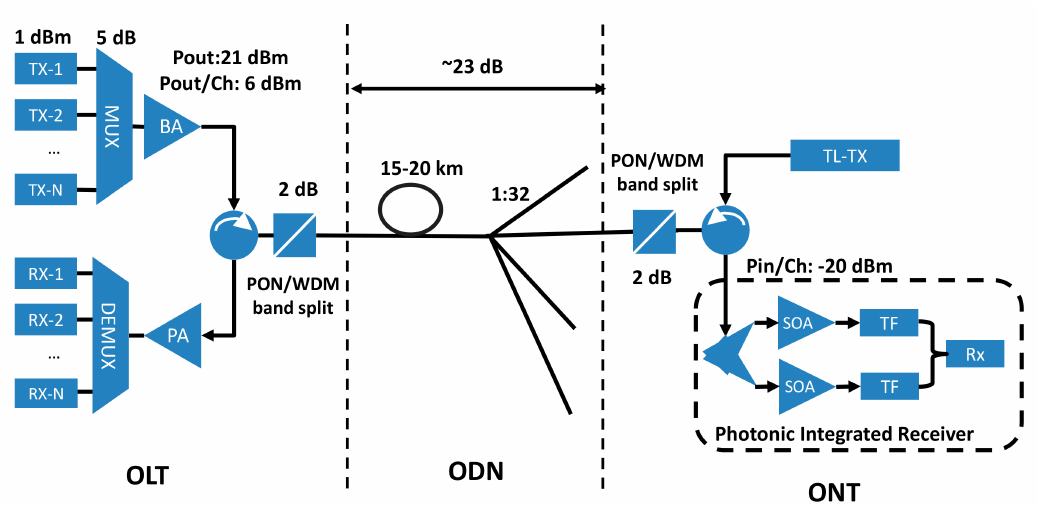
Figure 1. Lossless WDM PON architecture with proposed photonic integrated receiver. All link, coupling and on-chip losses are compensated by twin parallel integrated SOAs in the receiver. OLT: optical line terminal, ODN: optical distribution network, ONT: optical network terminal, TF: tunable